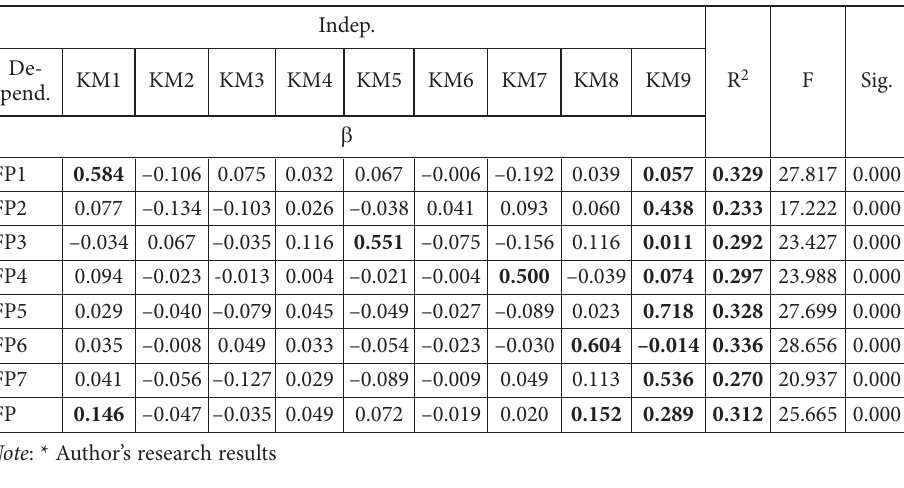
Table 3. Correlation coefficients between the dimensions of knowledge management and the dimen- sions of financial performance (items) and dimensions for domestic and foreign companies